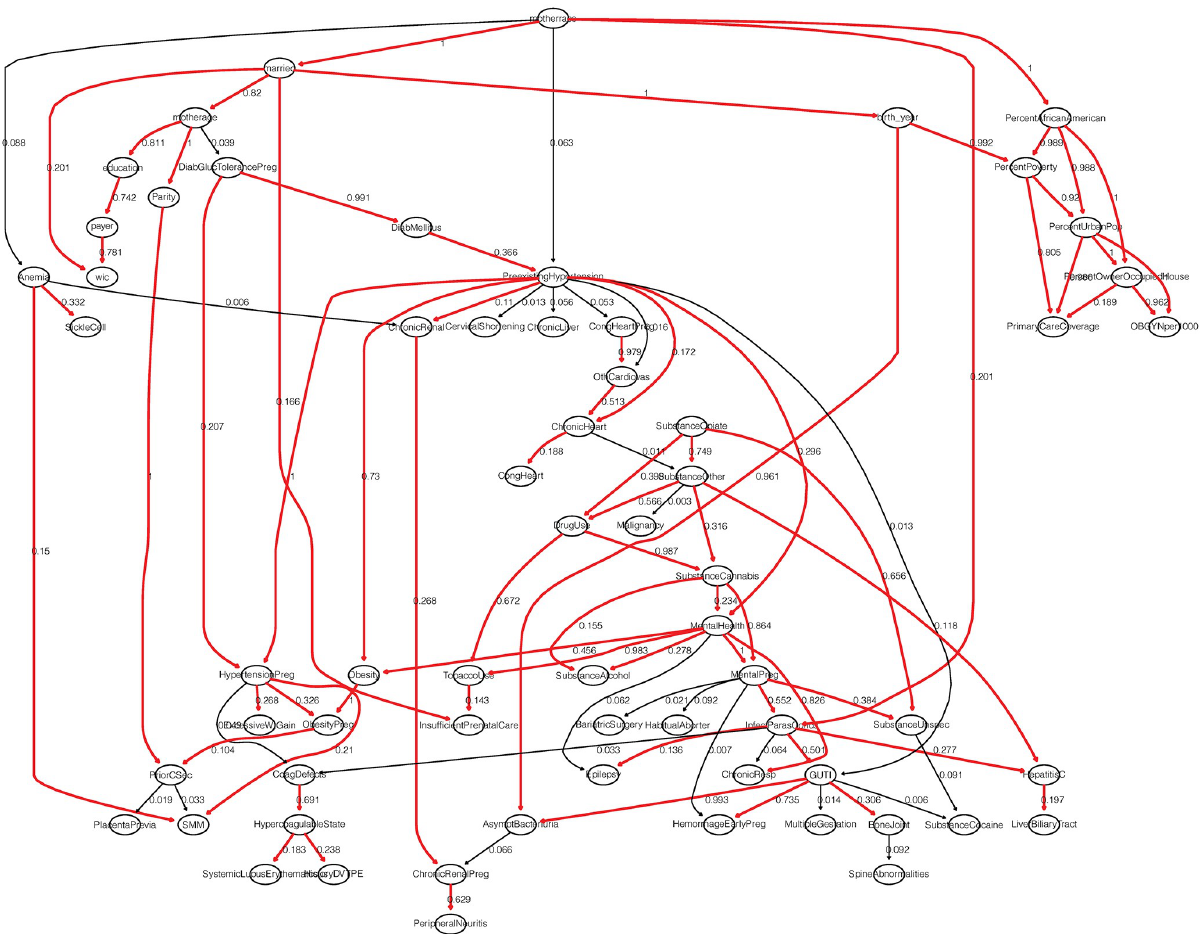
Fig 3. BN learned based on HC-BIC with proportion of occurrence of each arc in the bootstrap replicates.